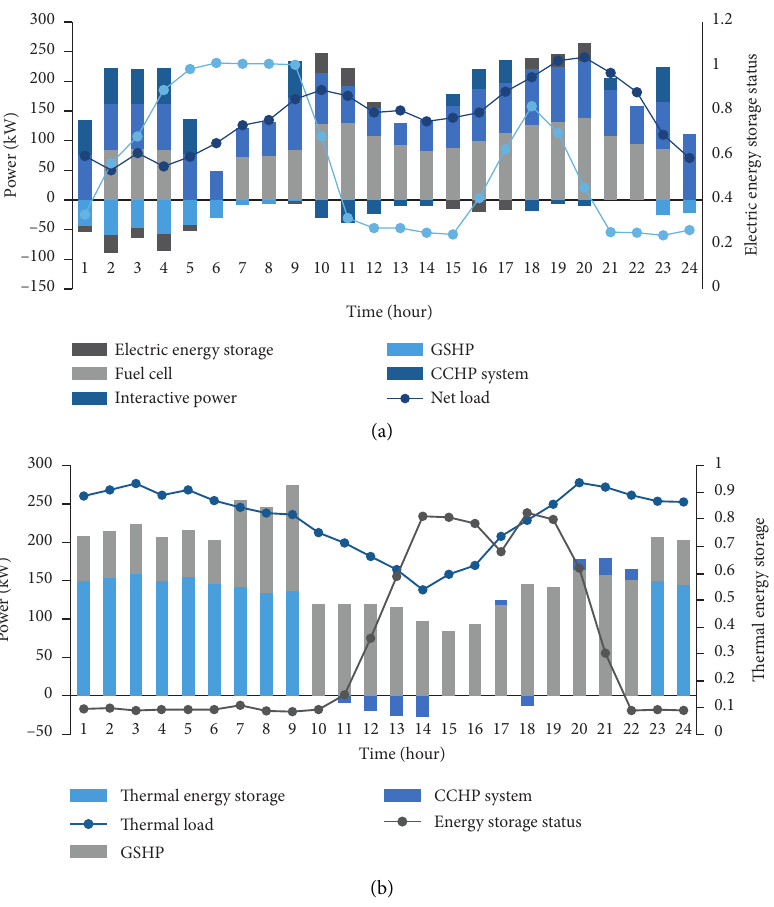
Figure 7: Optimization results in winter with heat pump and heat storage: (a) electric power; (b) thermal power. Table 4: Peak-shaving, valley-filling, and energy efficiency indicators under the two modes. Operation mode